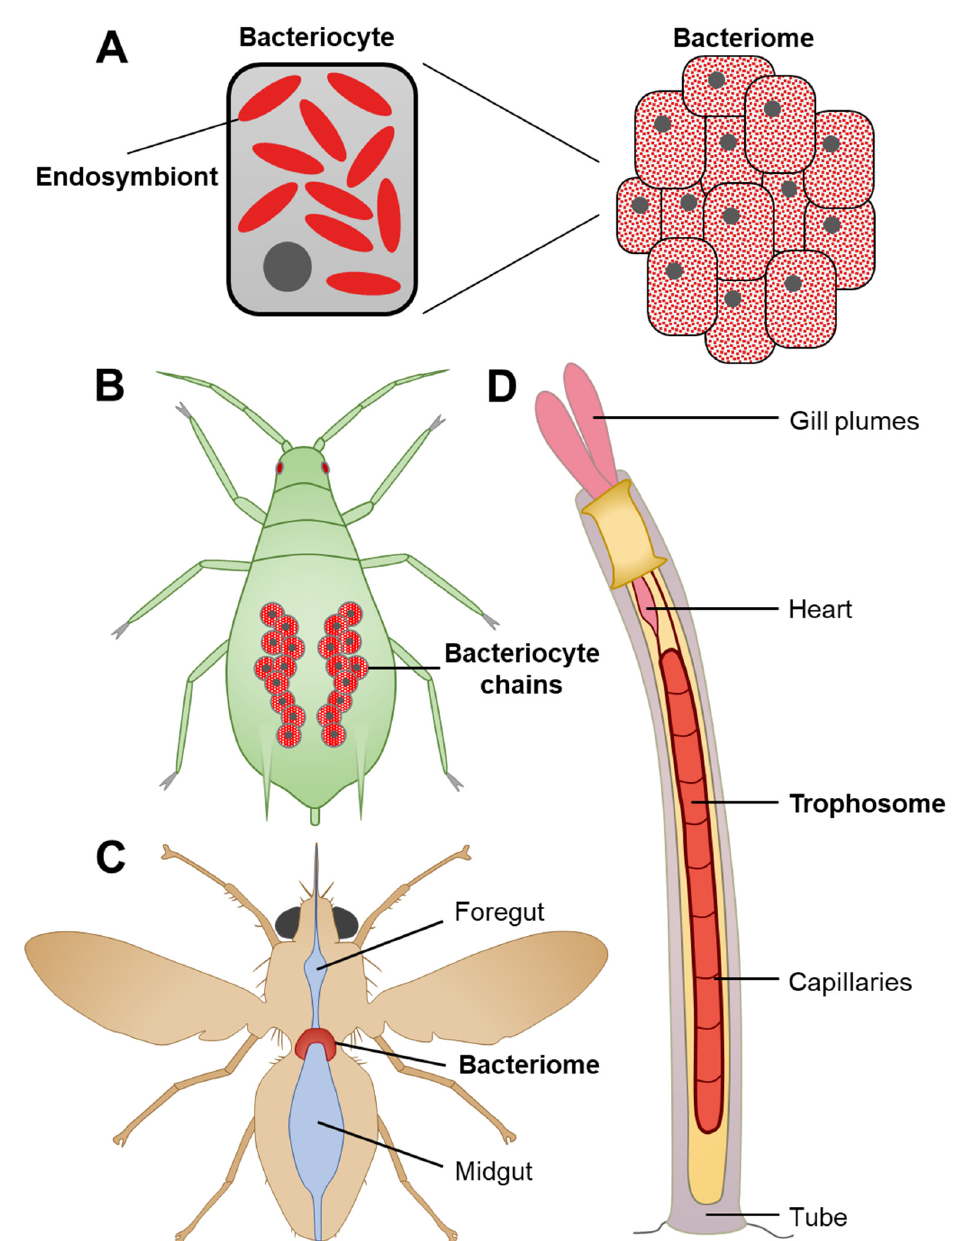
Figure 2. Morphological diversity of symbiotic structures. In organisms such as insects, high densities of endosymbionts are housed in specialized host cells, called bacteriocytes, that sometimes form a dedicated organ, the bacteriome ( A ). In the pea aphid A. pisum , giant bacteriocytes (diameter > 100 µm in adults) are grouped in two abdominal chains ( B ) [14]. They house B. aphidicola , which provides most essential amino acids to its sap-feeding host [63]. In the tsetse fly Glossina morsitans , bacteriocytes form a bacteriome around the gut ( C ) [67]. Its endosymbiont Wigglesworthia glossinidia synthesizes B vitamins that are absent in the fly’s hematophagous diet [68]. In the tube worm Riftia pachyptila , bacteriocytes form a trophosome that is directly linked to the circulatory system ( D ). This tubeworm species usually lives near hydrothermal vents. Carbon dioxide and hydrogen sulfide are internalized by the plume gills and transferred through the circulatory system to the trophosome, where chemosynthetic endosymbionts are able to metabolize those dissolved gases and to provide organic matter to their host